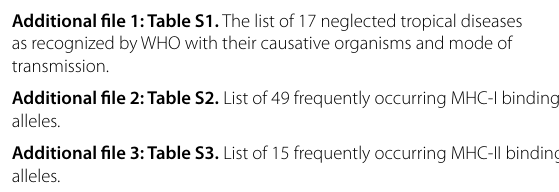
transmission. Additional file 2: Table S2. List of 49 frequently occurring MHC-I binding alleles. Additional file 3: Table S3. List of 15 frequently occurring MHC-II binding